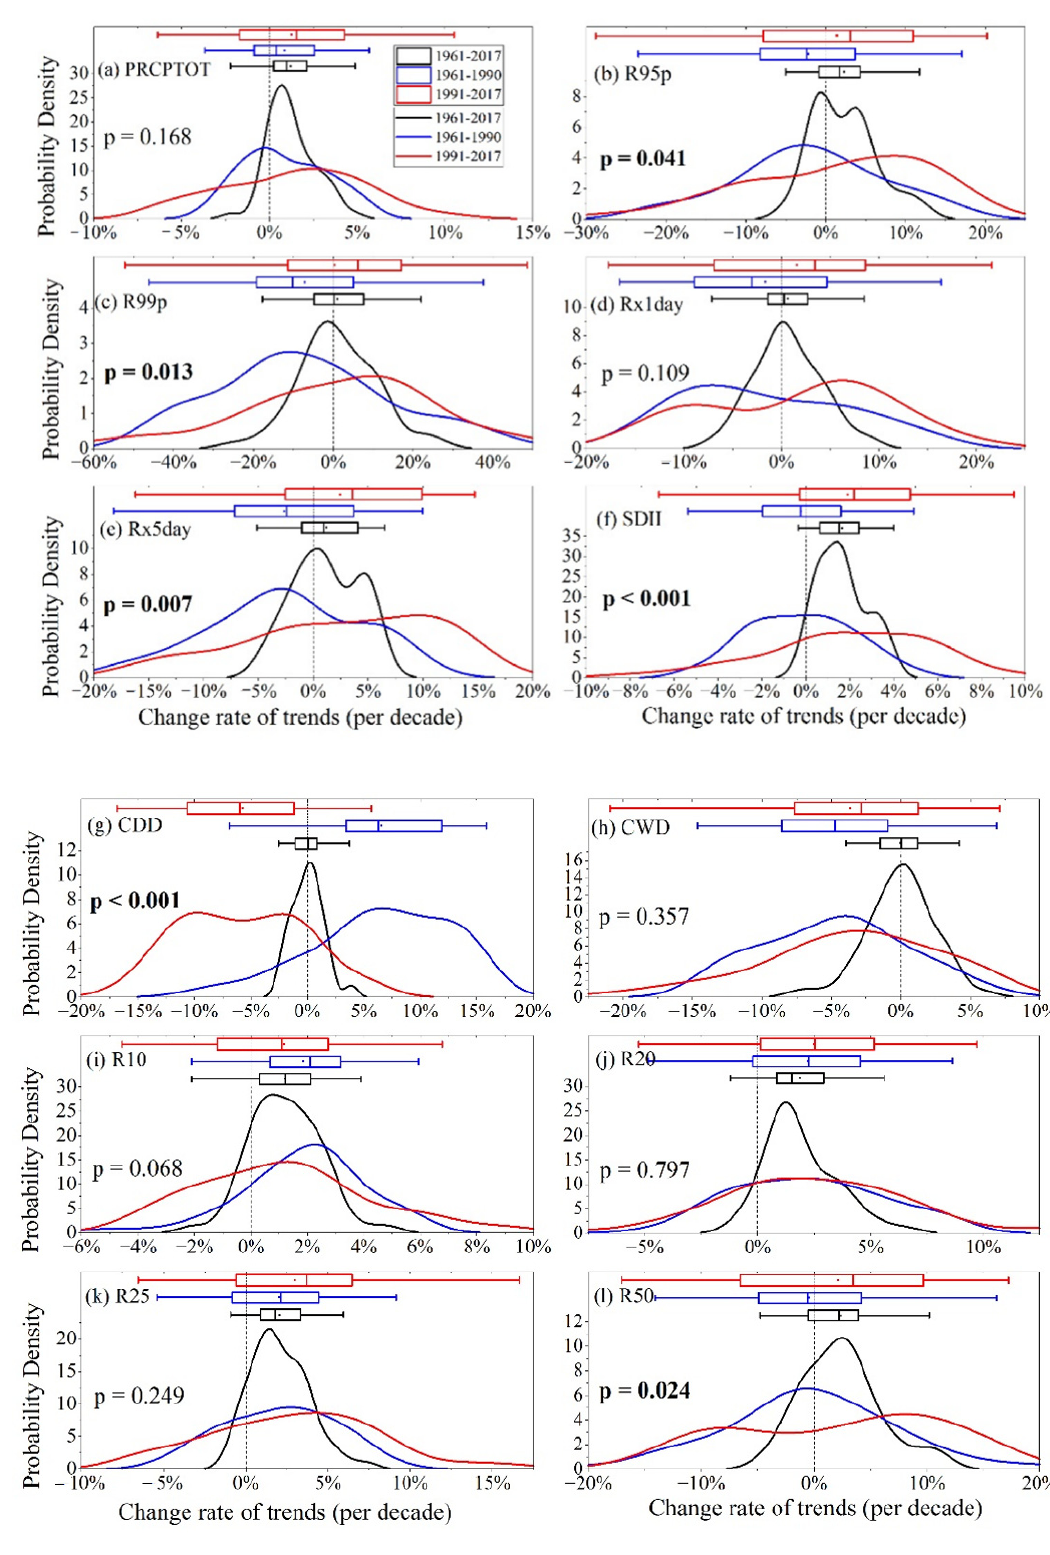
Figure 8. Magnitude (box plots) and probability density functions of normalized trends in precipitation extremes during 1961–2017, 1961–1990, and 1991–2017. The p values indicate whether the differences in the two distributions (1961–1990 and 1991–2017) for change rates of trends in precipitation extremes are significant, based on the two-sample Kolmogorov–Smirnov test.